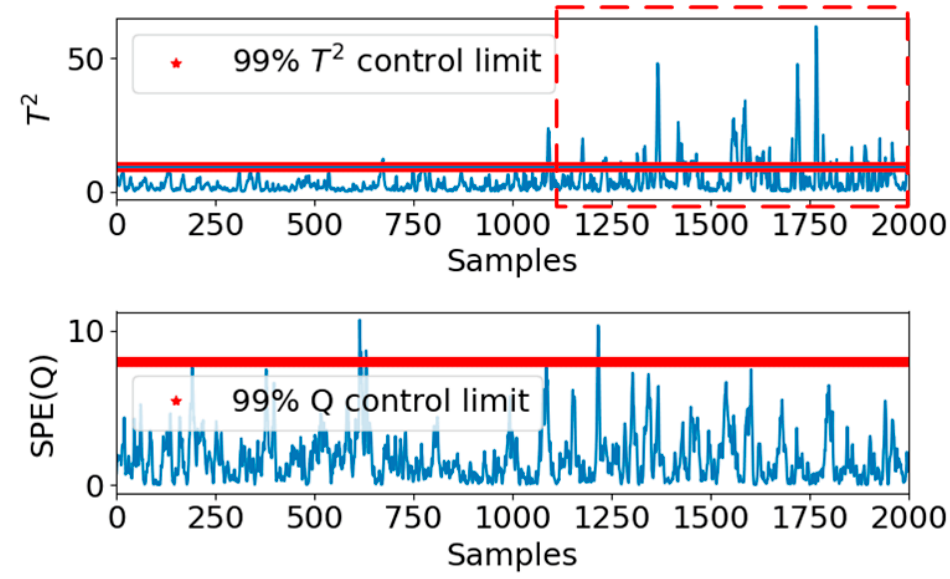
Figure 12. The results of principal component analysis.